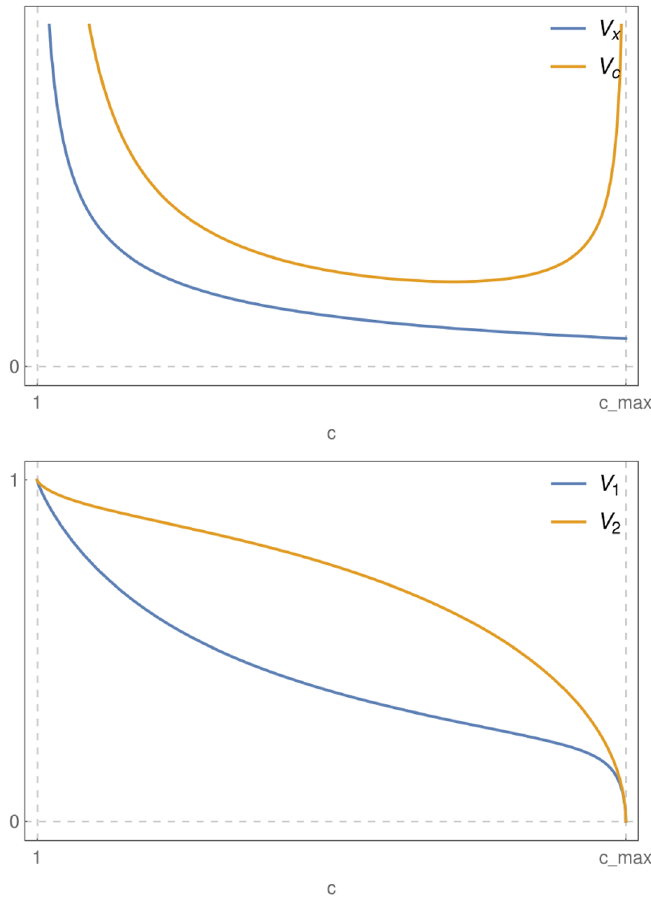
Figure 1 . The vielbeins of the induced metric for the allowed values of c